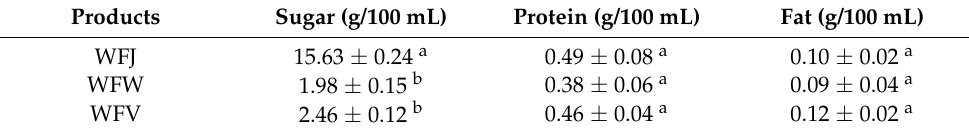
Table 2. Contents of nutrients of wolfberry fruit vinegar in the fermentation processes.